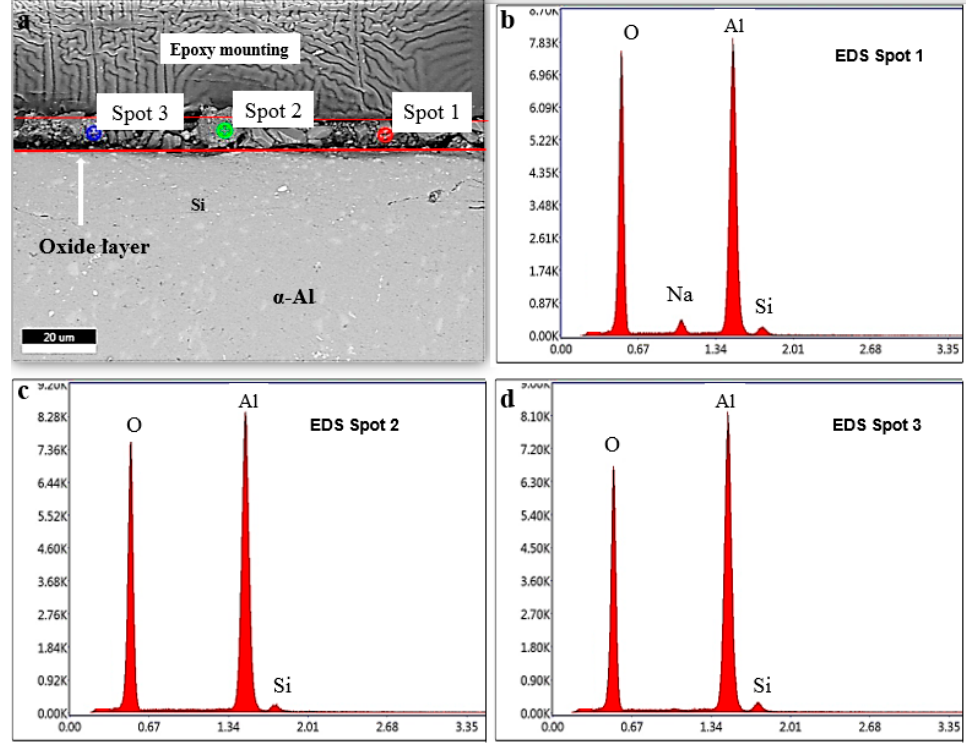
Figure 10. ( a ) Oxide layer of ECAPed A356 alloy and ( b – d ) EDX of oxide layer.